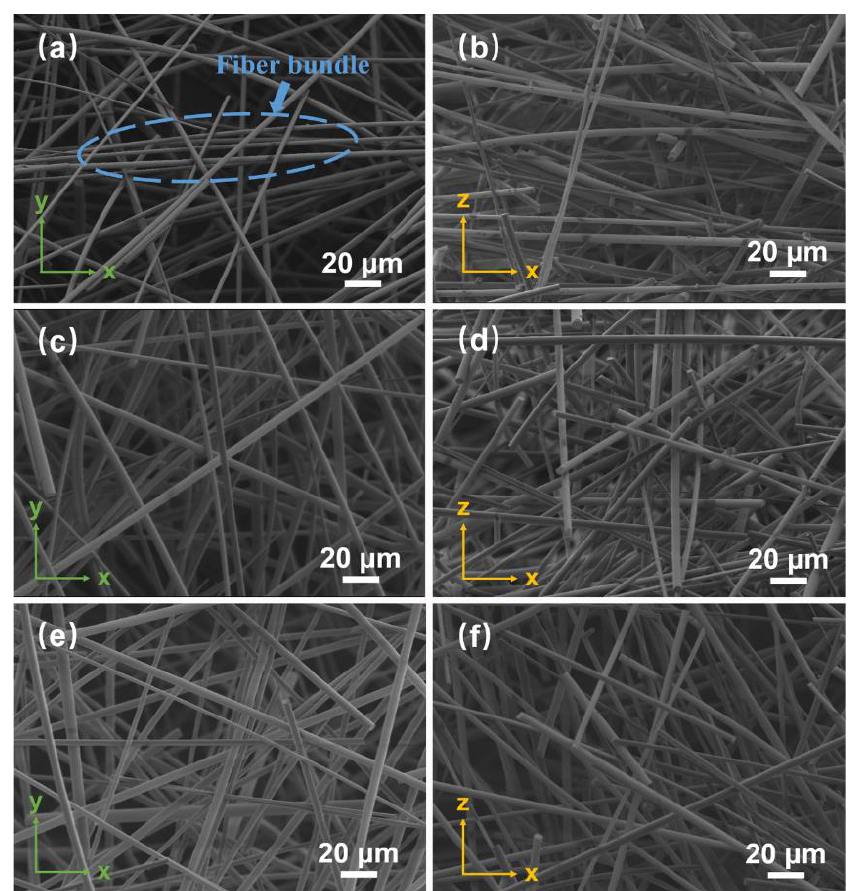
Figure 5. SEM images of SiO 2 fibrous porous materials with different SHMP contents. ( a , b ) 0.2 wt%, ( c , d ) 0.4 wt% and ( e , f ) 0.6 wt%.